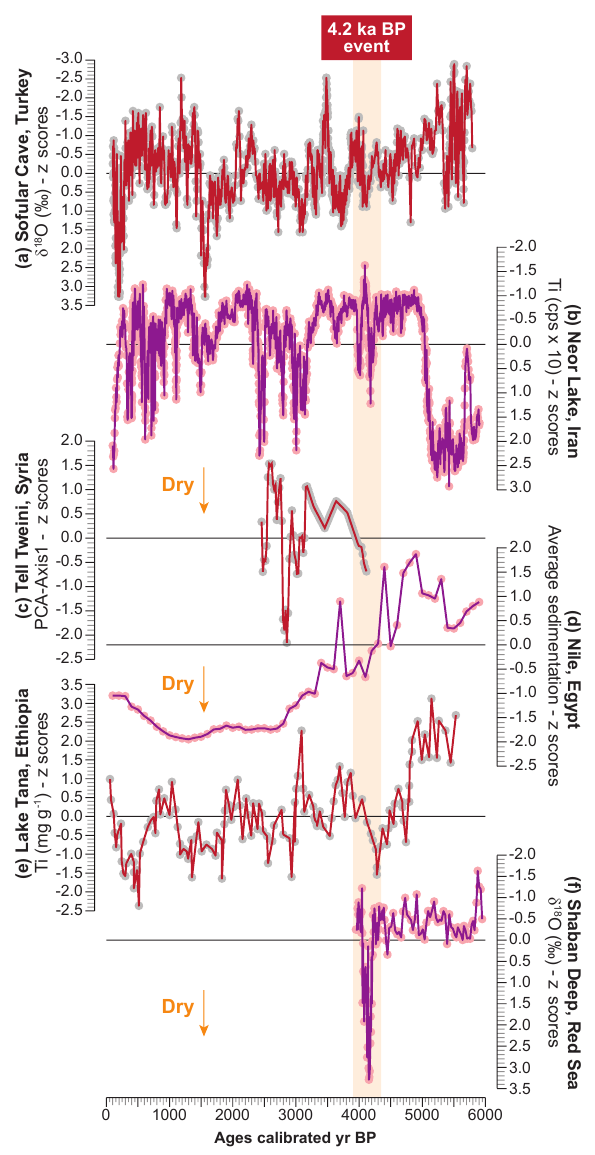
Figure 3. Paleoclimate series ( z score transformed), with the type of climate proxy noted. The orange vertical band represents the 4.2kaBP event. From top to bottom: Sofular Cave (Turkey; Gök- türk et al., 2011), Neor Lake (Iran; Sharifi et al., 2015), Tell Tweini (Syria; Kaniewski et al., 2008), the Nile (Egypt; Marriner et al., 2012), Lake Tana (Marshall et al., 2011), and the Shaban Deep (Red Sea; Arz et al.,